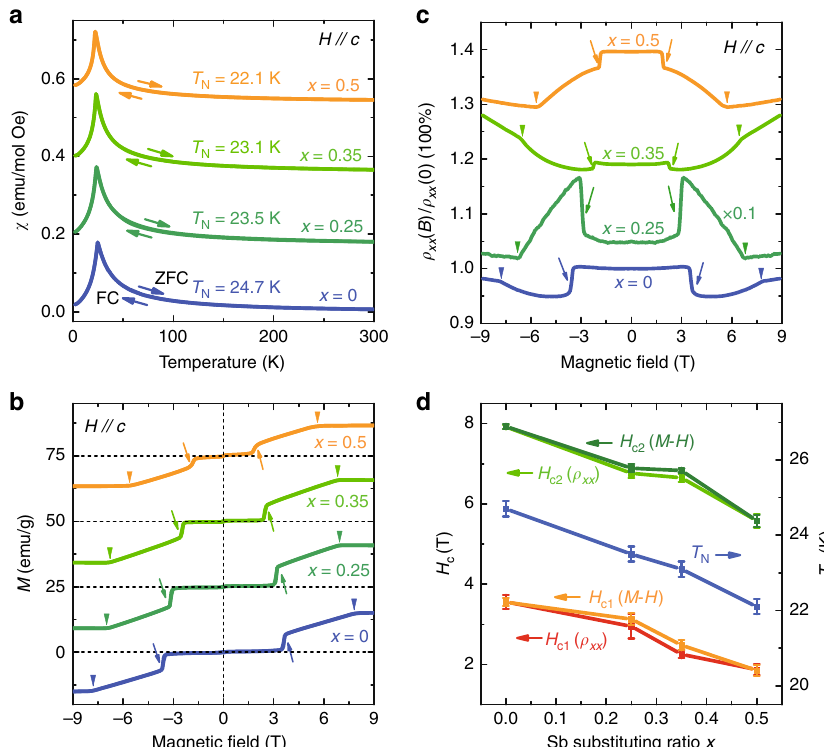
Fig. 3 Magnetism measurements of Mn(Sb x Bi (1 − x ) ) 2 Te 4 . a FC-ZFC curves of the samples with different values of x . The curves are offset for clarity. b , c Magnetization versus magnetic fi eld and the magnetoresistance of samples with different values of x . The curves are offset for clarity. d The evolution of the Néel temperature extracted from panel a and the corresponding critical fi eld for the kink ( H c 1 , H c 2 ) in different samples for various x extracted from b , c . Error bars correspond to standard